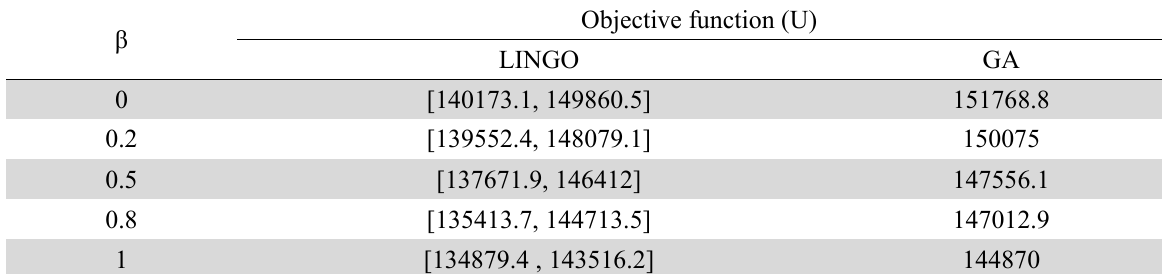
Objective function